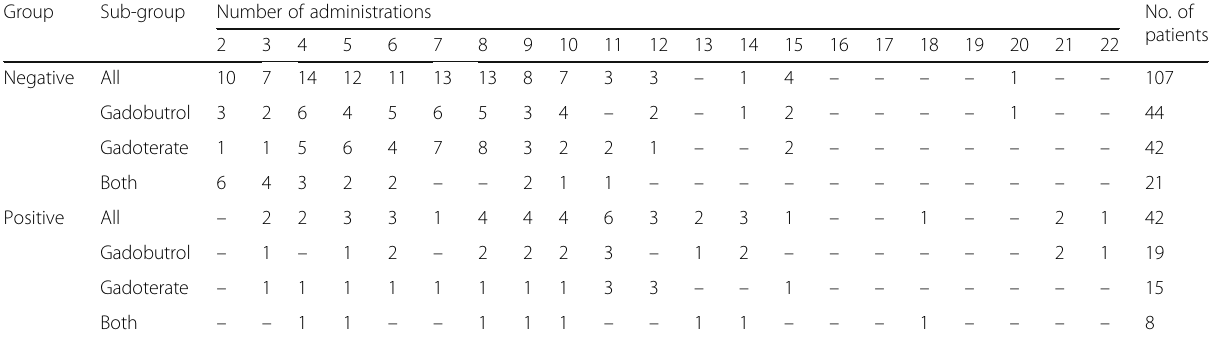
Table 2 Number of GBCA administrations given to patients with and without visible T1-hyperintensity of the DN Group Sub-group Number of